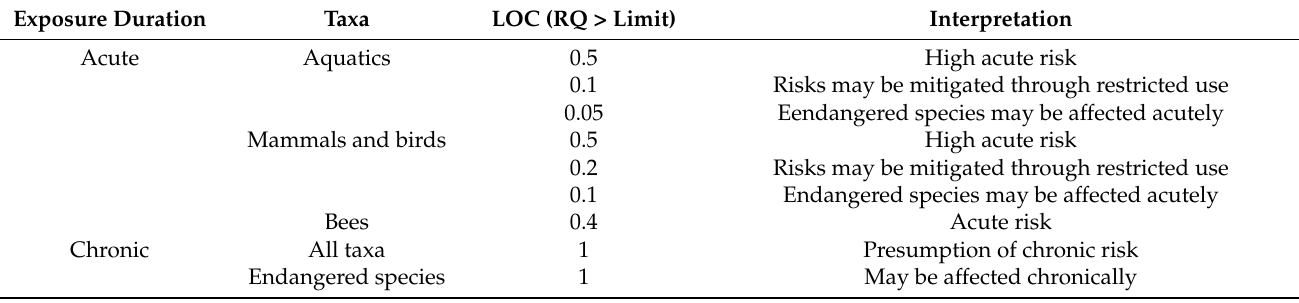
Table 1. Levels of Concern (LOC) used in USEPA pesticide risk assessments